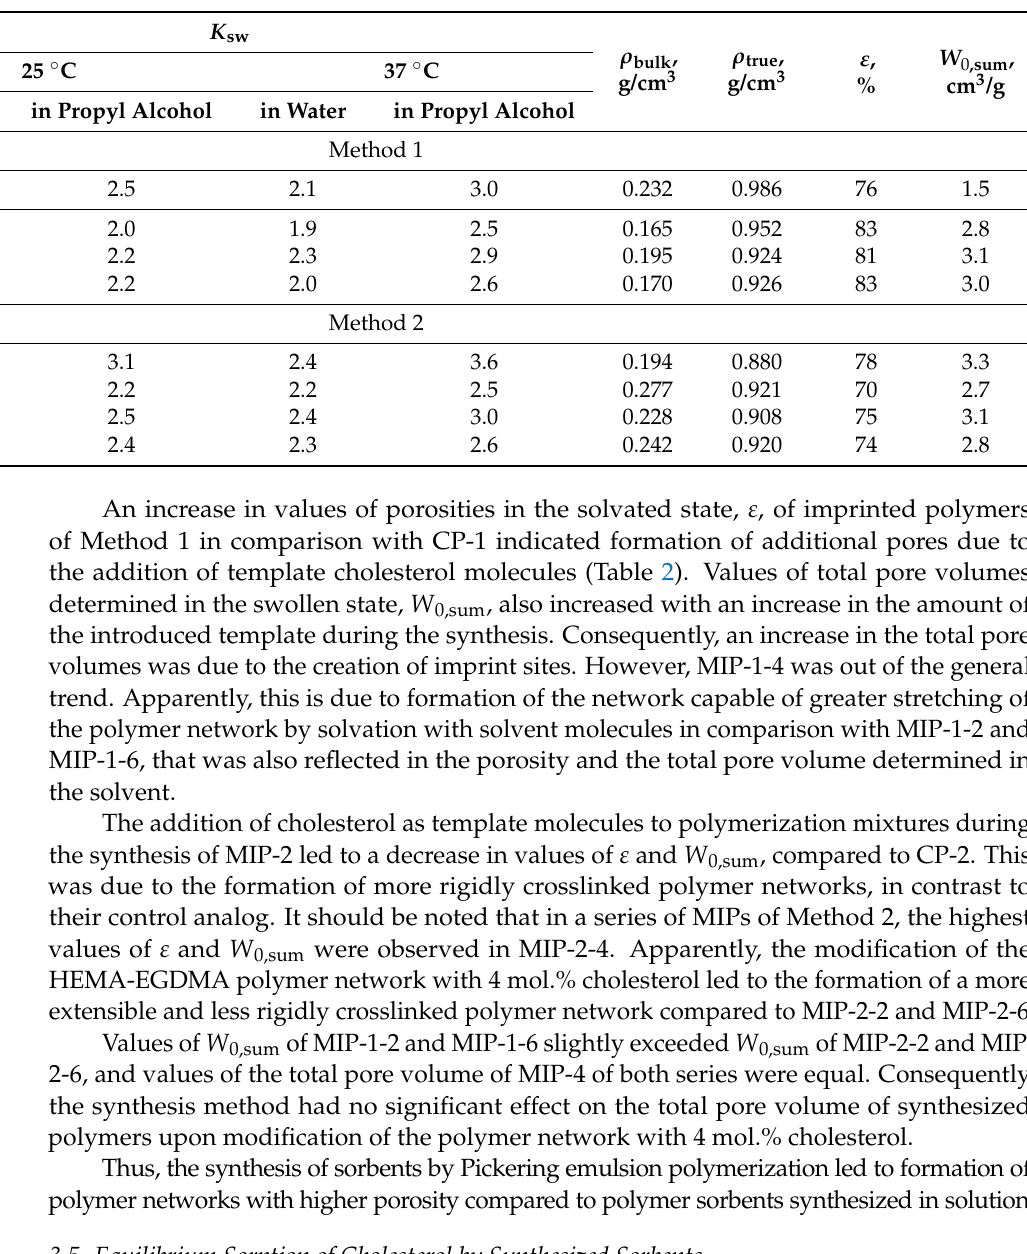
Table 2. Physicochemical properties of synthesized